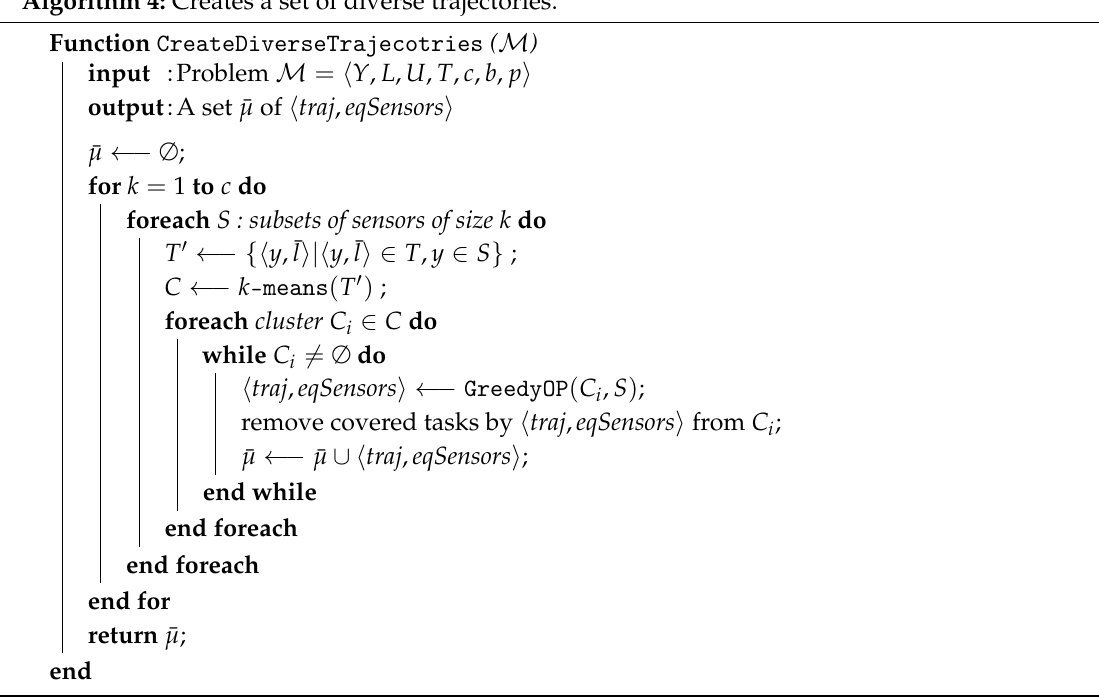
Algorithm 4: Creates a set of diverse trajectories. Function CreateDiverseTrajecotries ( M )